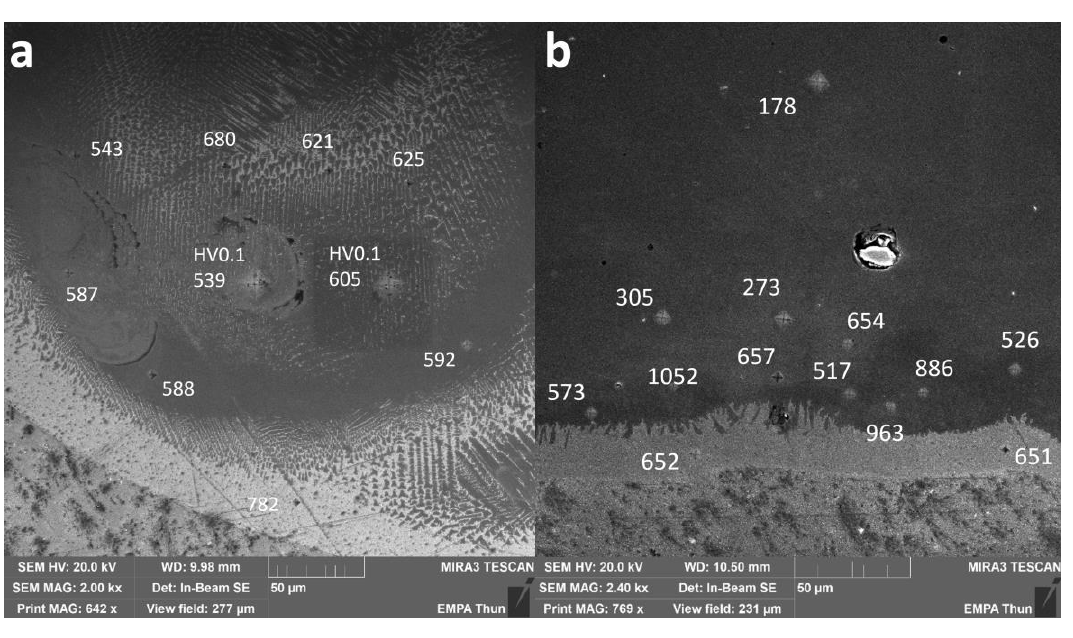
Table 2. Compositions obtained by EDS point analyses with corresponding microhardness and